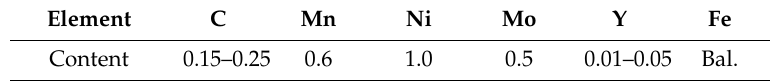
Figure 1. Scanning electron microscopy (SEM) image of low-alloy steel powder. Table 1. Chemical compositions of the low-alloy steel powder used in this work (wt %).